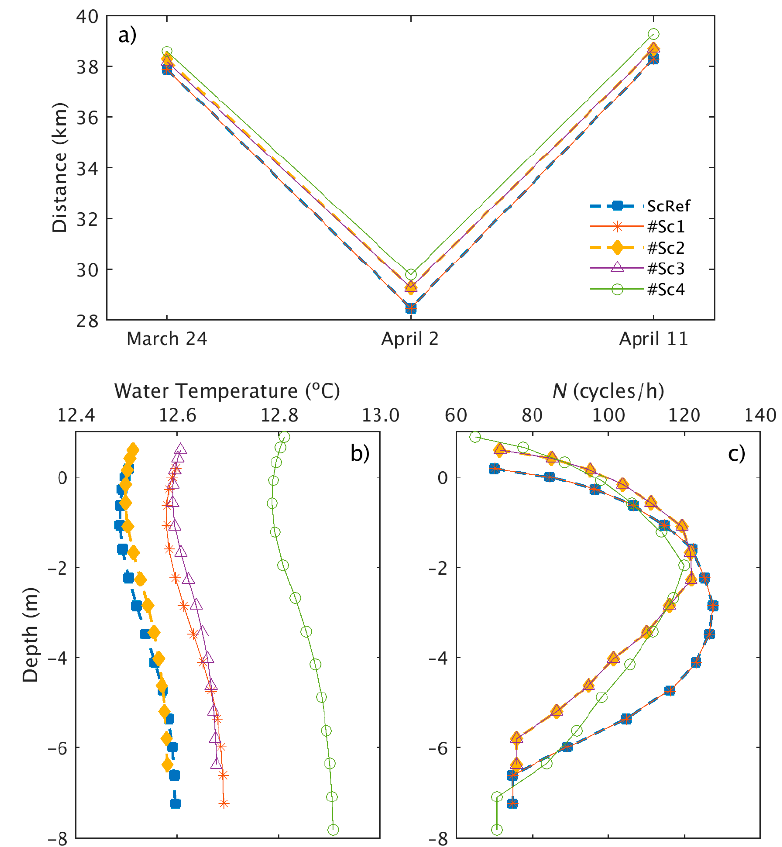
Figure 11. ( a ) Distance from the longitudinal section beginning (estuary mouth) (km) of the isohaline 2 on 24 March, 2 April, and 11 April; the vertical profiles corresponding to the limit of salt intrusion of ( b ) water temperature (°C) and ( c ) Brunt–Väisälä frequency (cycles/h) on 2 April for all